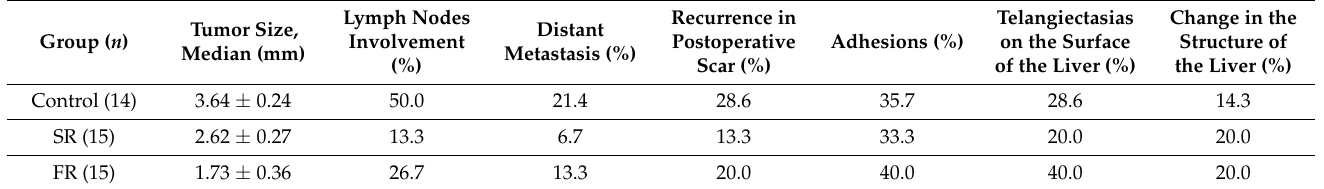
Table 2. Summarized results of the surgical examination of rats after SOR and SOR-releasing nanocarriers administration. Lymph Nodes Recurrence in Telangiectasias Change in the Tumor Size, Distant Group ( n ) Involvement Postoperative Adhesions (%) on the Surface Structure of Median (mm) Metastasis (%) (%) Scar (%) of the Liver (%) the Liver (%) Control (14) 3.64 ± 0.24 50.0 21.4 SR (15) 2.62 ± 0.27 FR